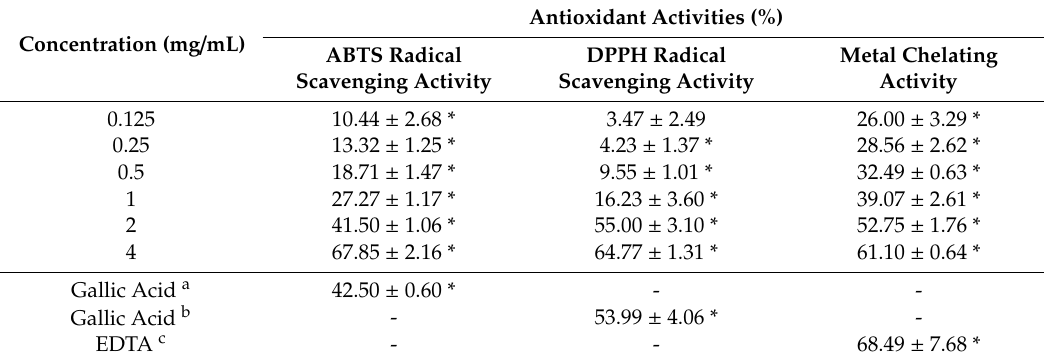
Table 1. Antioxidant activities of methanolic extract of strain MUSC